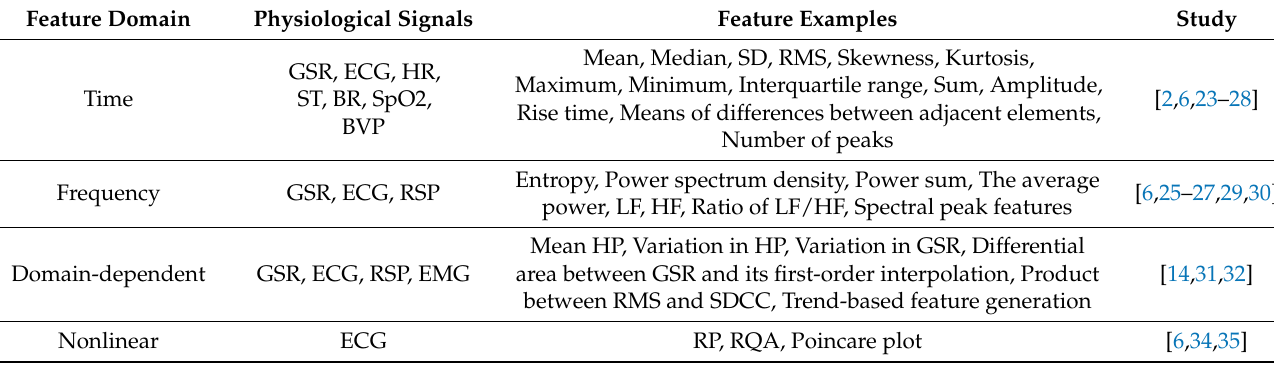
Table 1. Type of features often used in stress recognition studies using physiological signals. Feature Domain Physiological Signals Feature